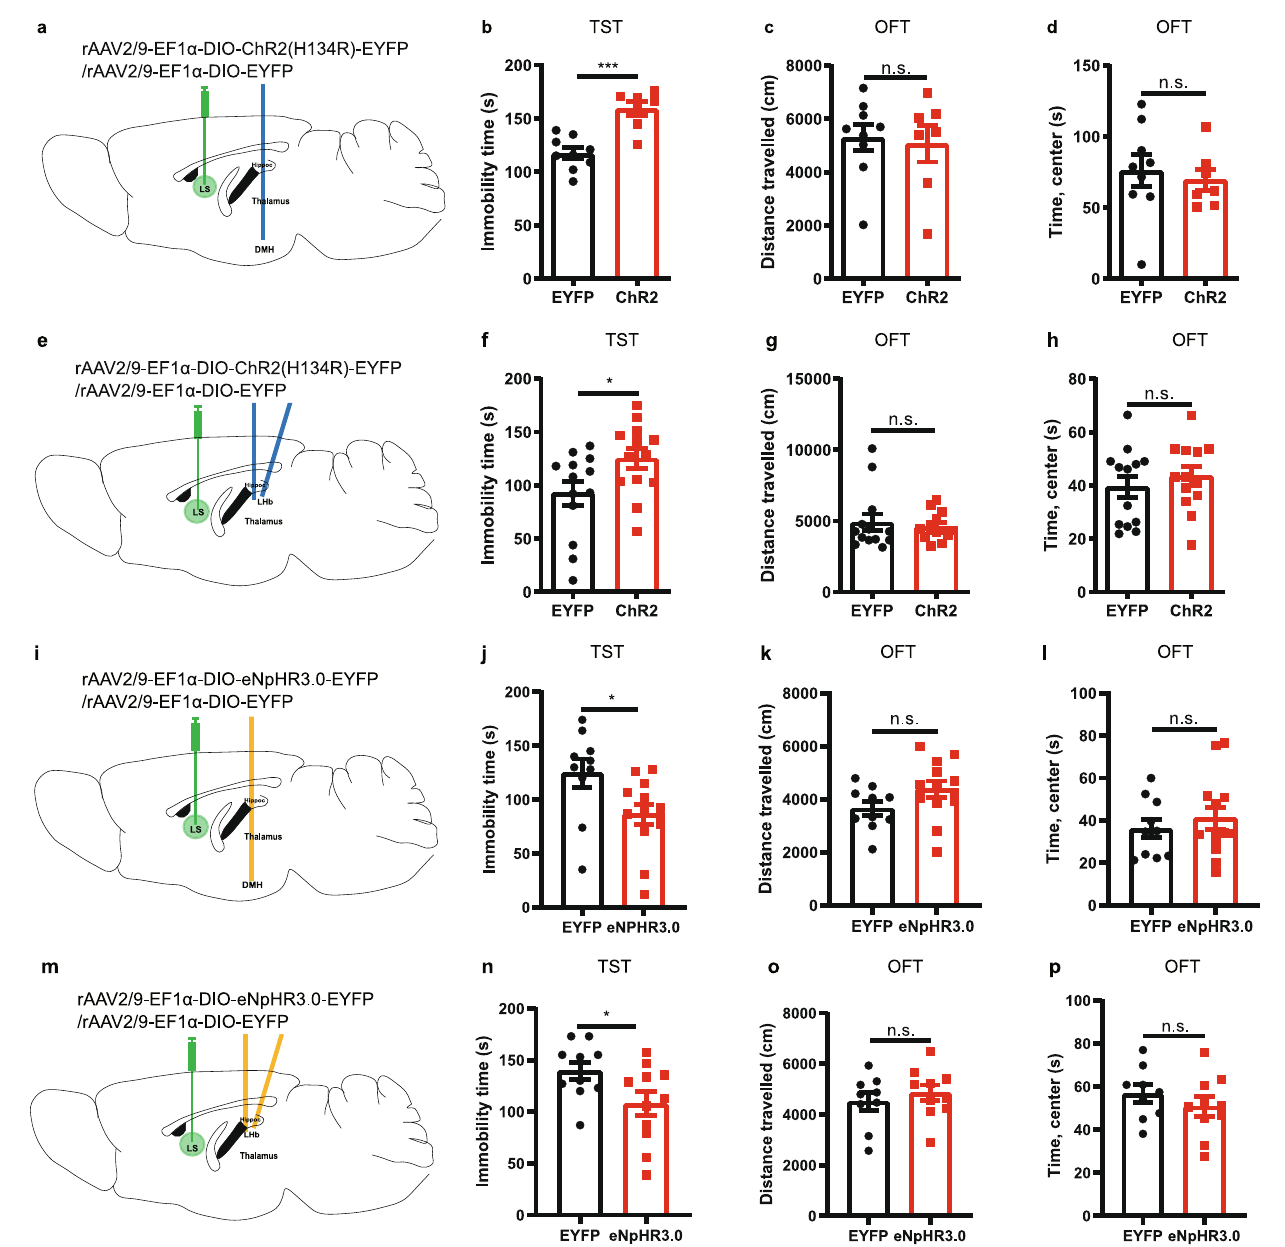
Fig.5|Optogeneticmodulationoftheprojectionterminalsinthedorsomedial hypothalamus (DMH) and lateral habenula (LHb) of A 2A R-containing